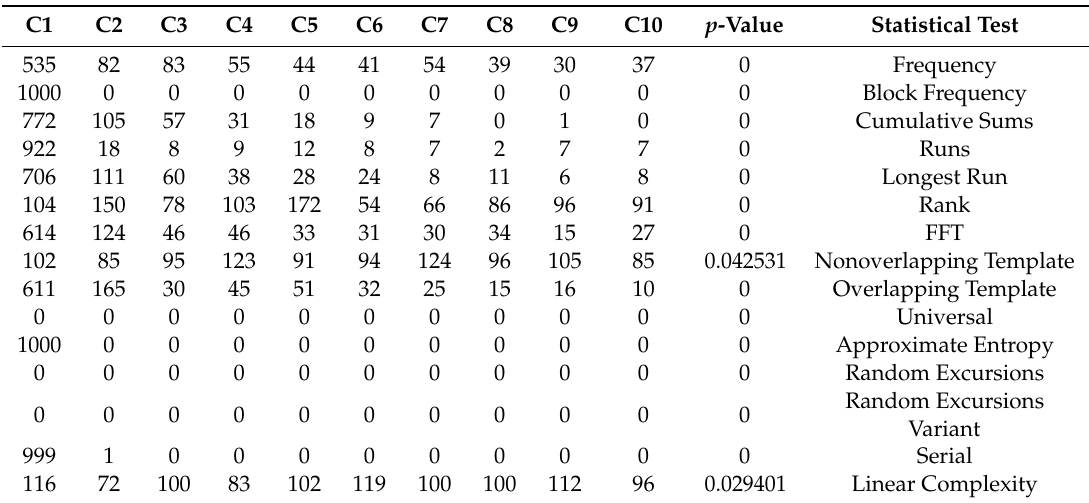
Figure 9. Comparison of the di ff erent input bit lengths in the NIST test. Table 5. NIST test results with 10 million input